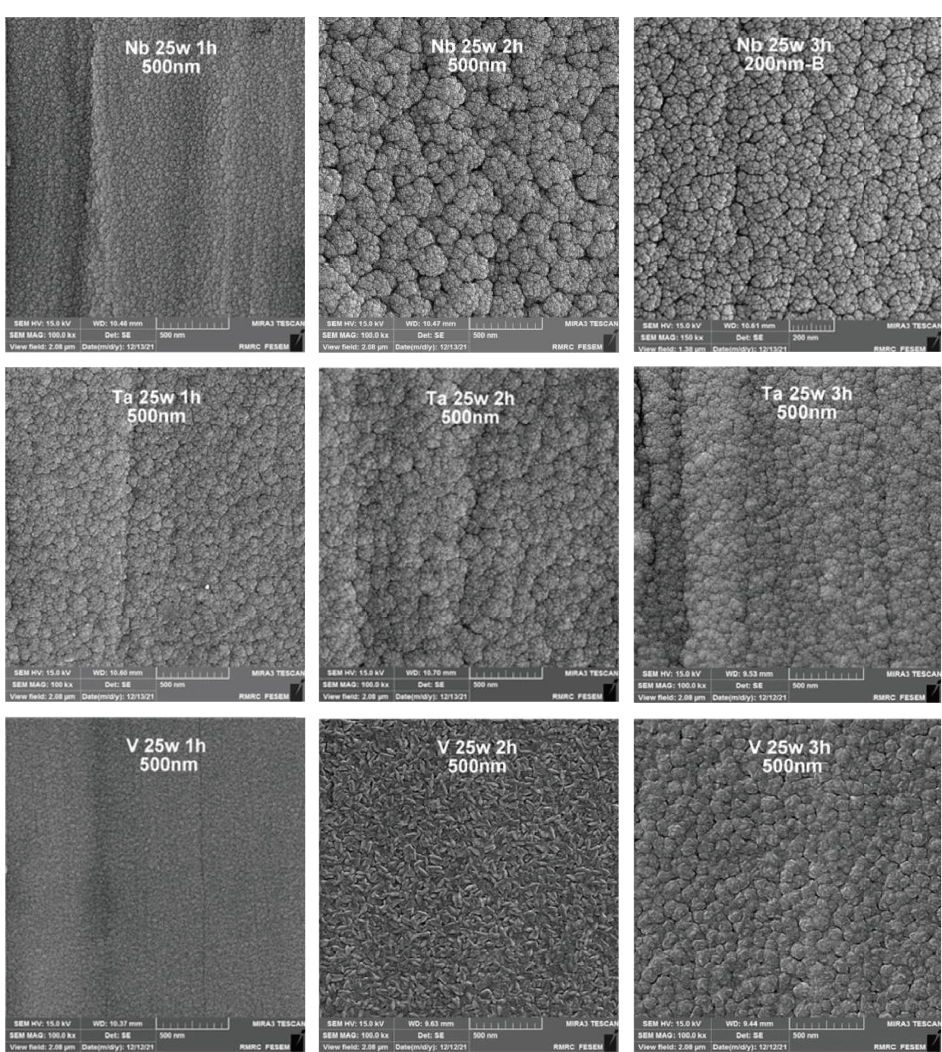
Figure 4: Morphology of the nanocoating particles of Nb, Ta, and V at diferent sputtering times. Table 2: Comparisons of nanocoating thickness at diferent sputtering times (1, 2, and 3hours) and for diferent coating materials (Nb, Ta, and V) using the one-way ANOVA